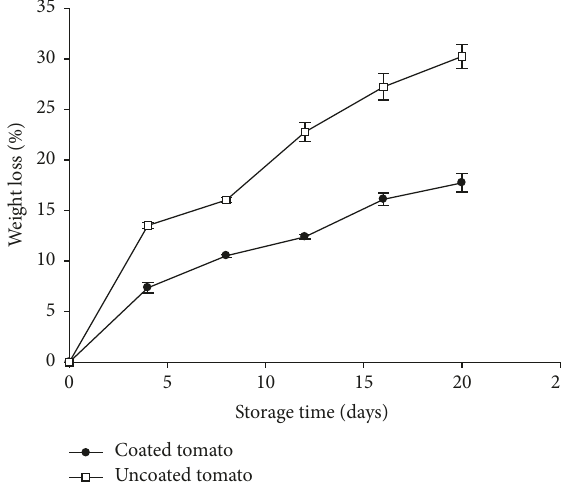
Figure 2: Effect of guar gum coating on weight loss of Roma tomatoes during a 20-day storage period ( 22 ± 2 ∘